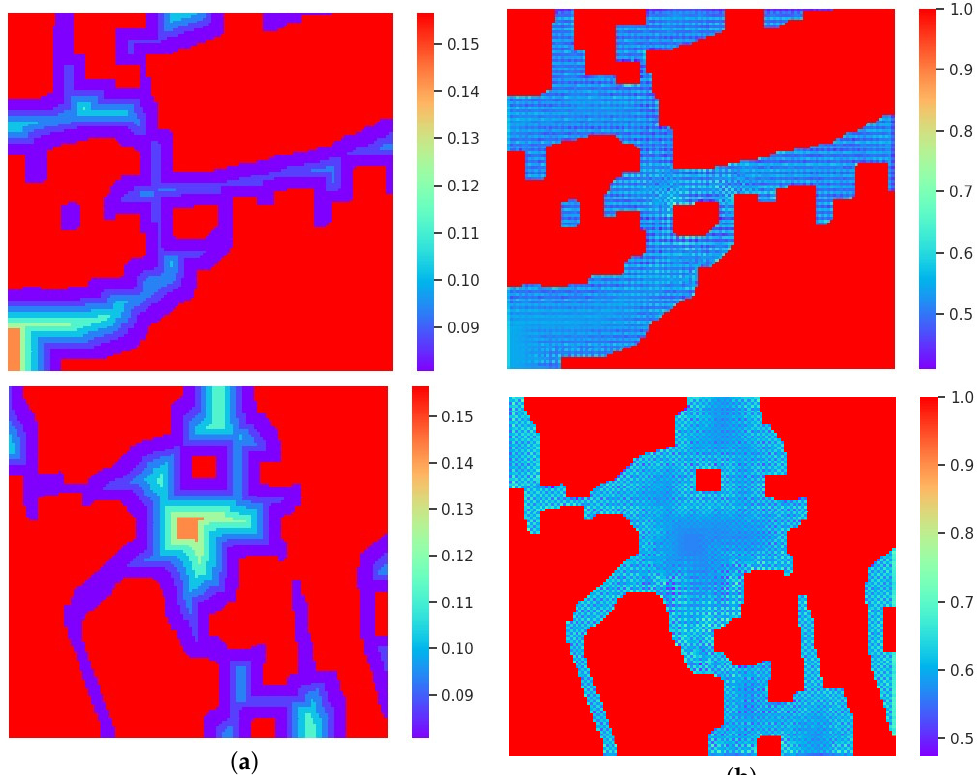
Figure 9. The visualization of the hard weight map and soft weight map. ( a ) is the hard weight map and ( b ) is the soft weight map.